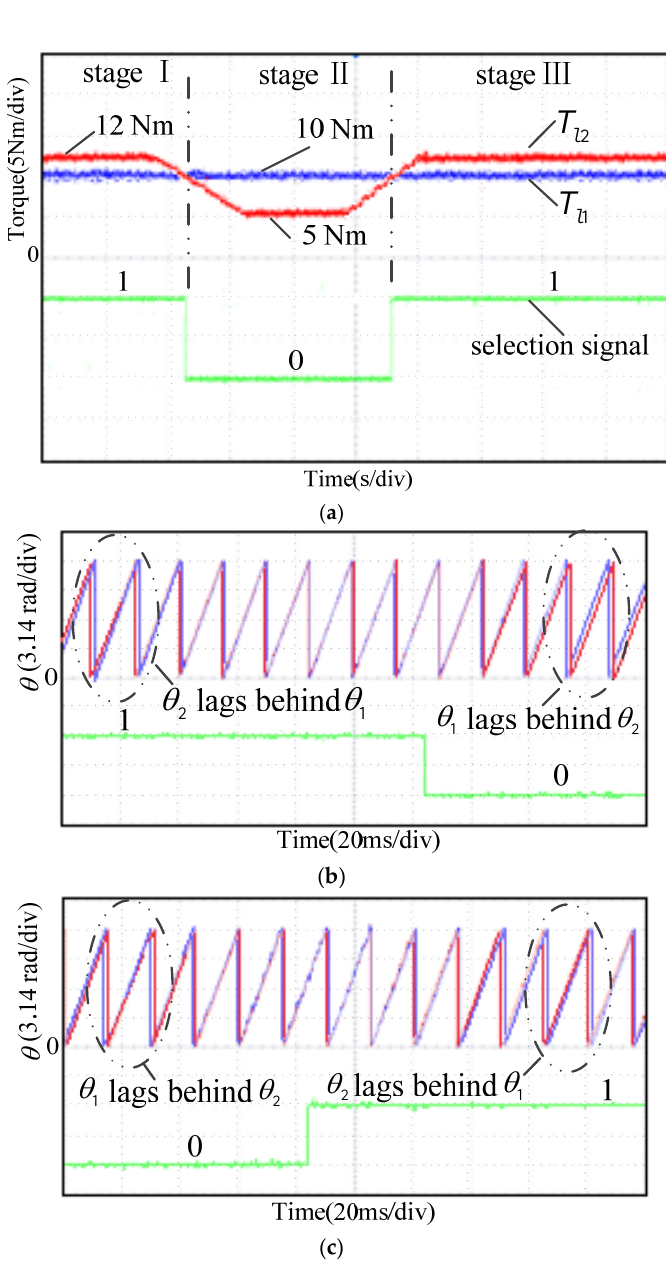
Figure 8. Variation of the load torque and transition of the selection signal. ( a ) Variation of the selection signal and load torques under different conditions; ( b ) variation of the selection signal (from 1 to 0) and variation of the angular position (from θ 2 lagging behind θ 1 to θ 1 lagging behind θ 2 ); and ( c ) variation of the selection signal (from 0 to 1) and variation of the angular position (from θ 1 lagging behind θ 2 to θ 2 lagging behind θ 1 ).